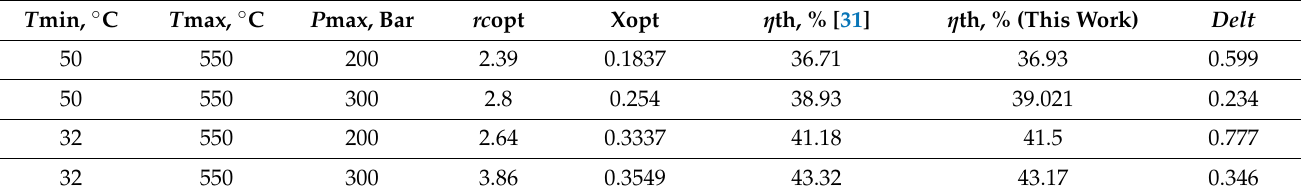
Table 2. Validation of Brayton supercritical cycle with recompression.